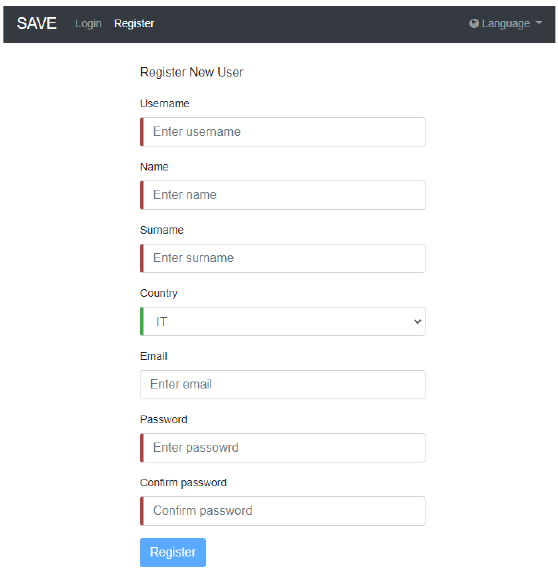
Figure 1. User account creation.